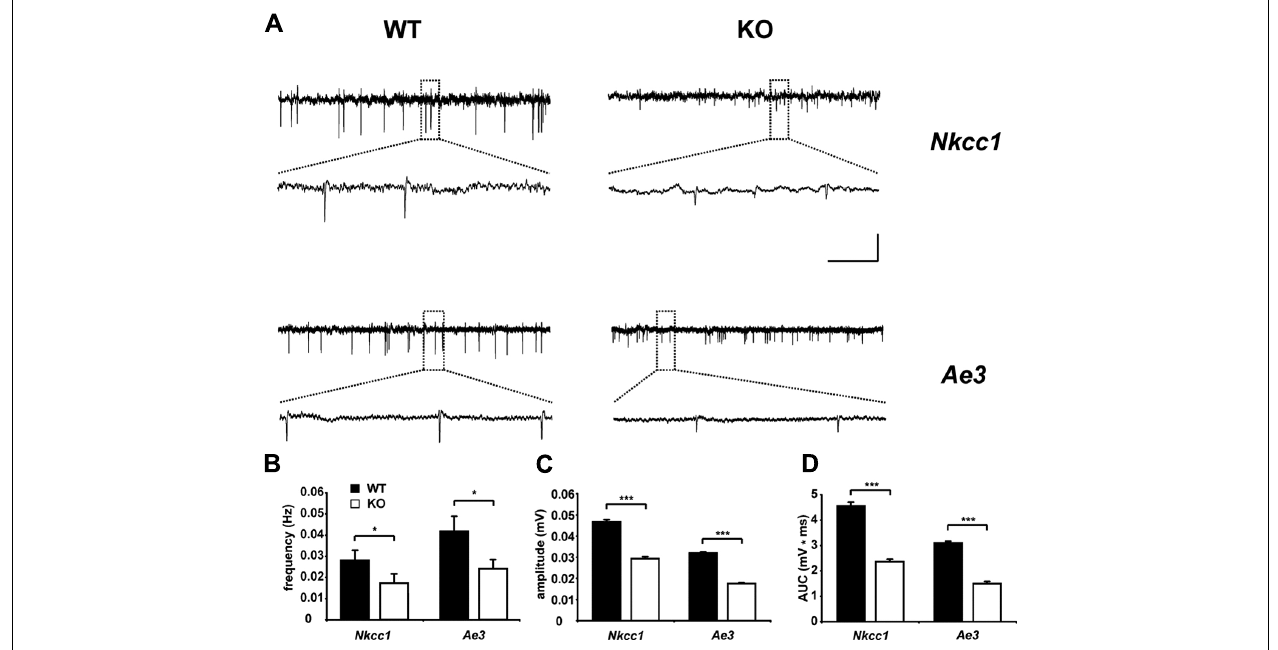
(enlargement); vertical, 0.04 mV. Quantification of frequency (B) , amplitude (C) , area under curve (AUC), and (D) of single spontaneous electrical events. The asterisks indicate significant difference (* p < 0.05, *** p < 0.001, t -test). Error bars indicate SEM. Reprinted from Pfeffer etal.